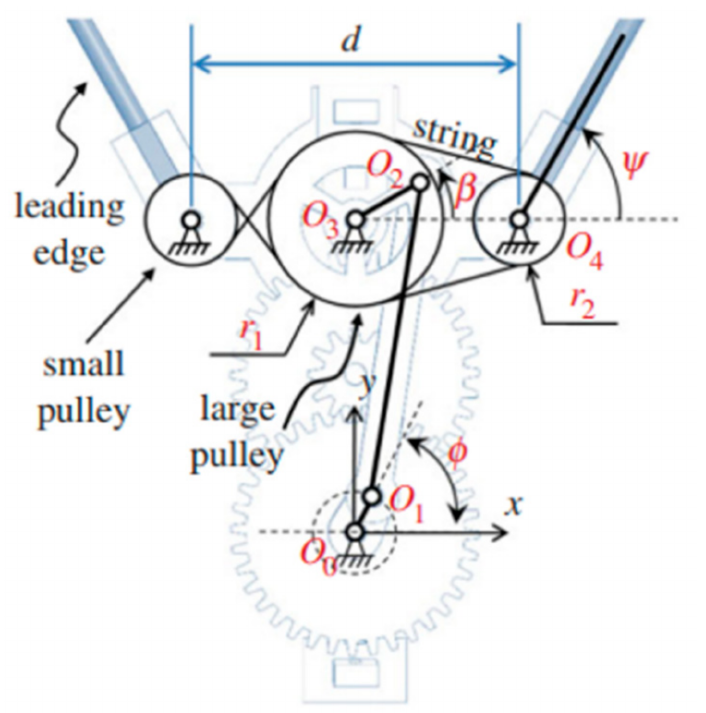
Figure 2. Scheme of the flapping mechanism in KU-Beetle. Reprinted from Ref. [42].